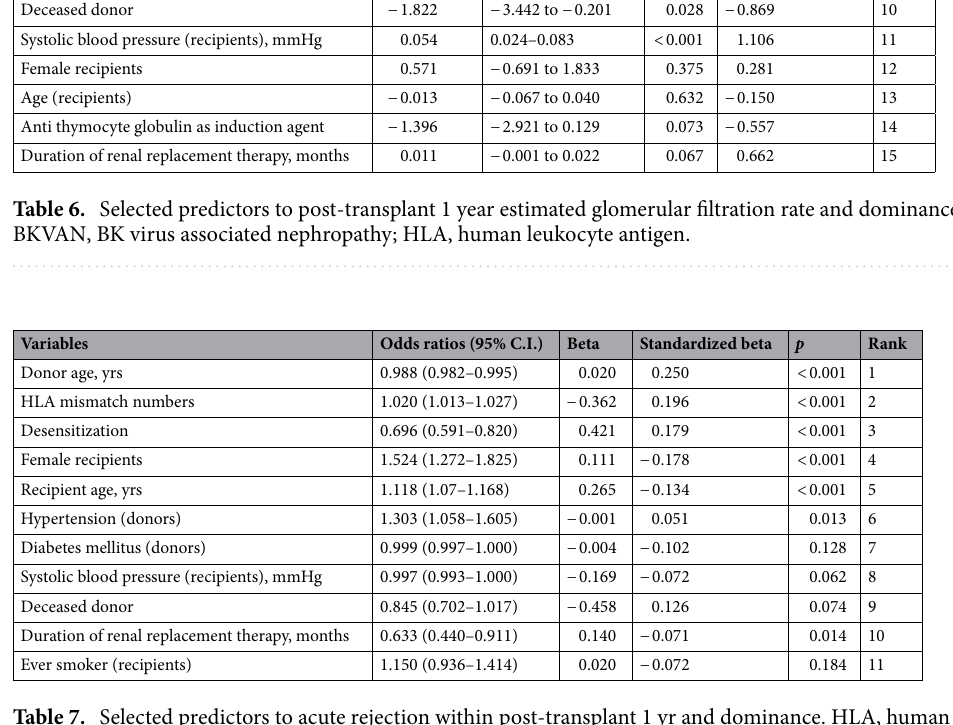
Table 7. Selected predictors to acute rejection within post-transplant 1 yr and dominance. HLA, human leukocyte antigen.